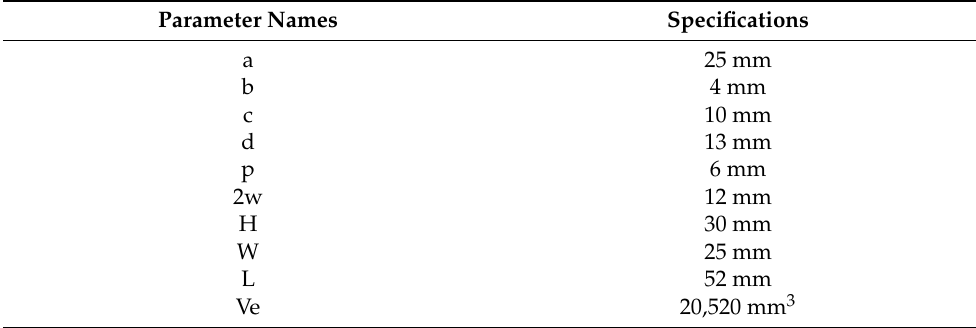
Table 2. Design Parameters of Proposed Transformer Structure.